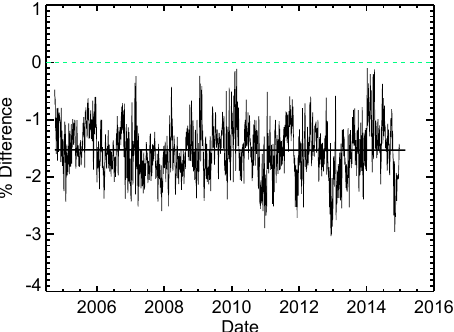
Figure 2. A comparison of OMI ozone with average ozone from an ensemble of 76 Northern Hemisphere Dobson–Brewer stations, with linear fit also shown. Weekly mean percent difference of OMI ozone minus ground-based ozone is plotted.